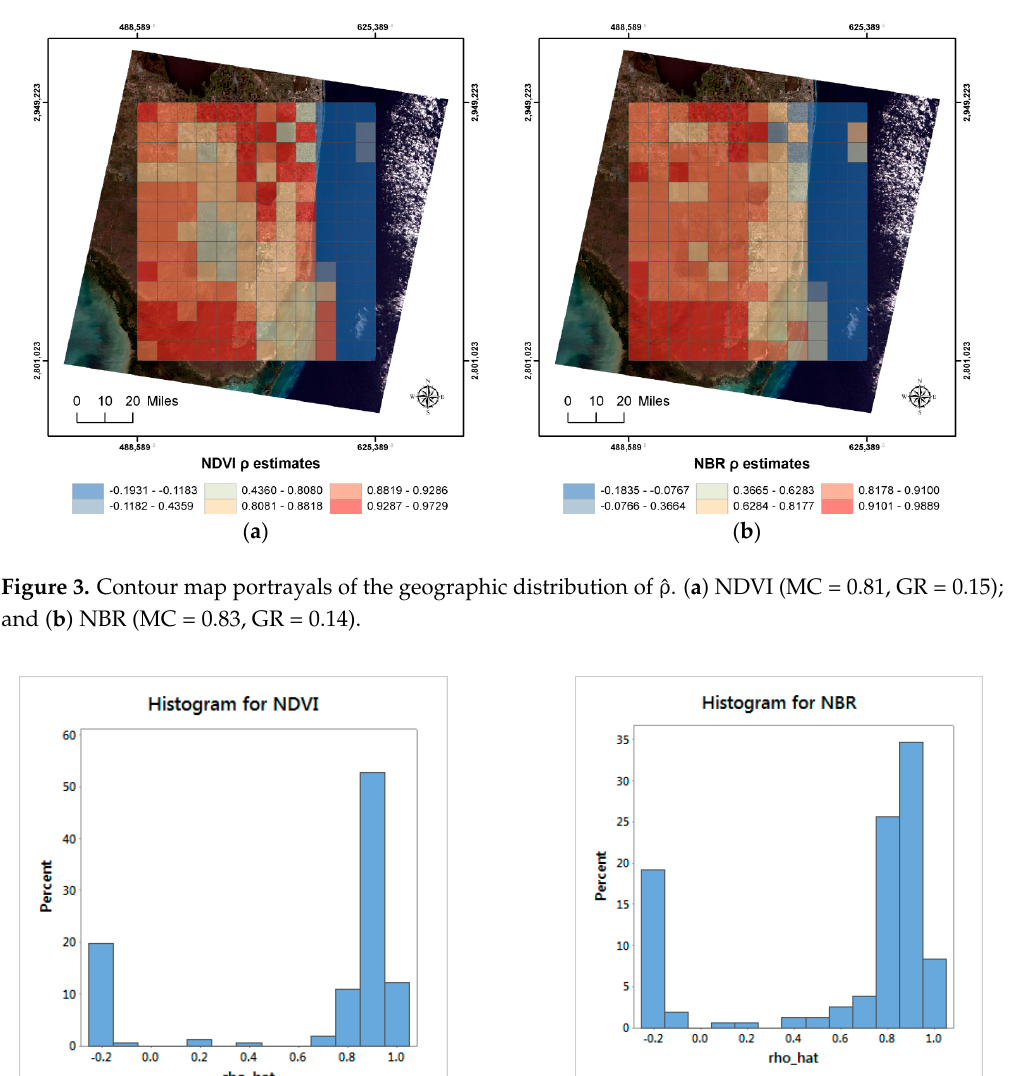
Figure 4. The frequency distribution of ˆ ρ for the 156 coterminous quadrats partitioning the Florida Everglades region. ( a ) NDVI; and ( b ) NBR.